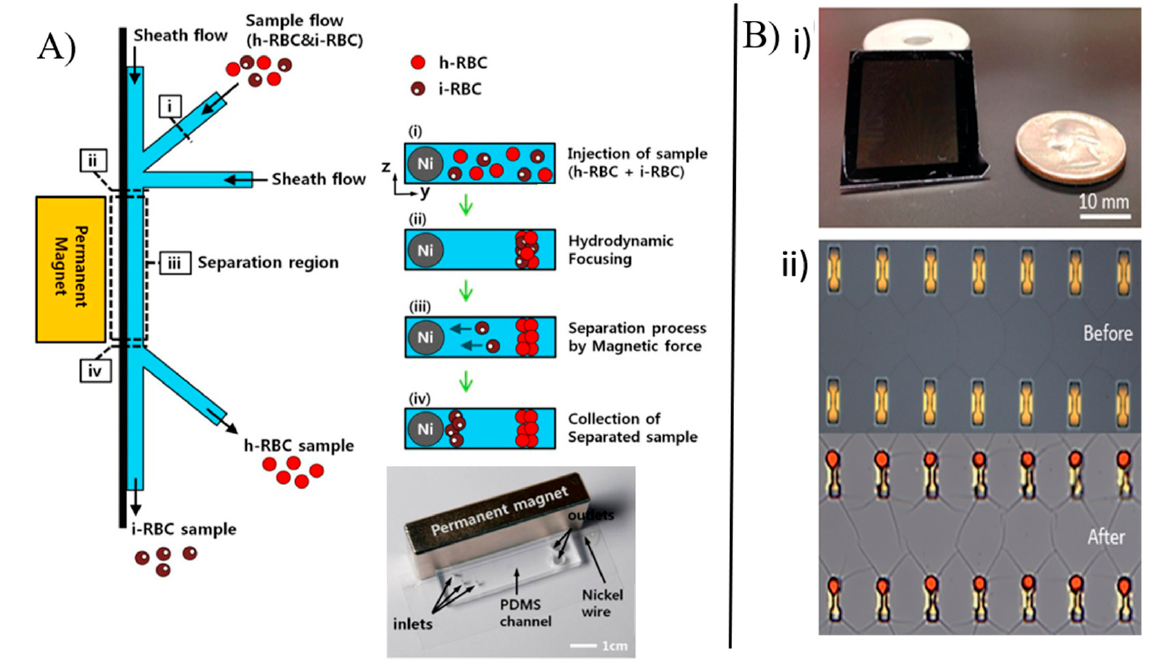
Figure 3. Magnetophoresis-based cell trapping ( A ) Magnetophoretic system displaying an image of the microfluidic device consisting of an embedded nickel wire with an external permanent magnet and separation of malaria-infected RBCs (i-RBCs) from healthy RBCs (h-RBCs) due to paramagnetic behavior of hemozoin in infected RBCs (note the four stages of separation (i–iv) that occur at four locations along a microfluidic channel consisting of a nickel wire showing the separated state compared to the initial position of the mixture) (reproduced with permission from [81]); ( B ) (i) Image of the MACS device with (ii) an arrangement of dumbbell shaped microwells before and after magnetic beads deposition for magnetophoretic separation and analysis of single CD4+ cells (reproduced with permission from [82]).